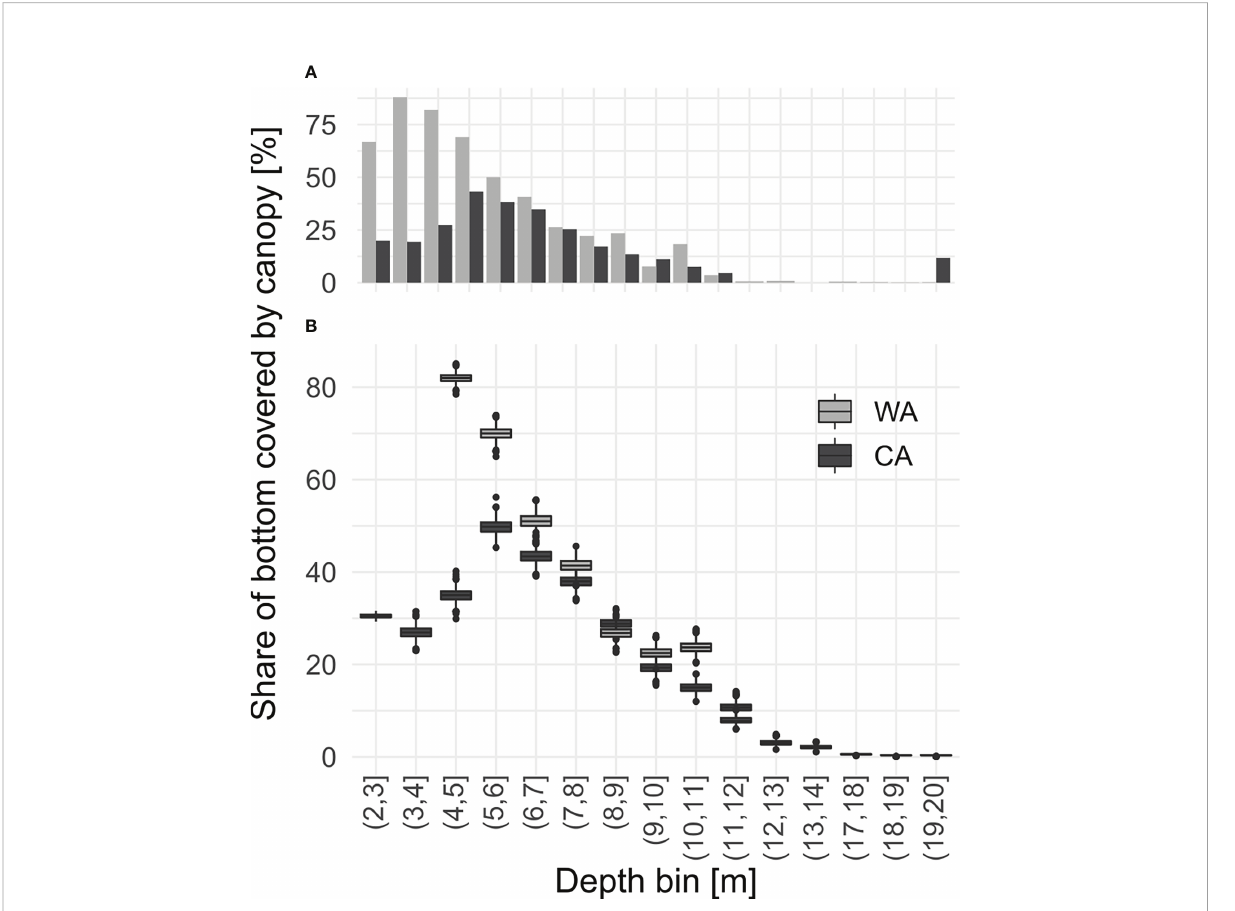
FIGURE 4 Algal coverages of inhabitable bottom averaged for distinct depth bins in sites Warm Arctic (WA) and Cold Arctic (CA): (A) based on all observations, (B) calculated from 1000 randomly selected samples within the given depth bin permuted 9999 times; boxplots represents distribution of values in all